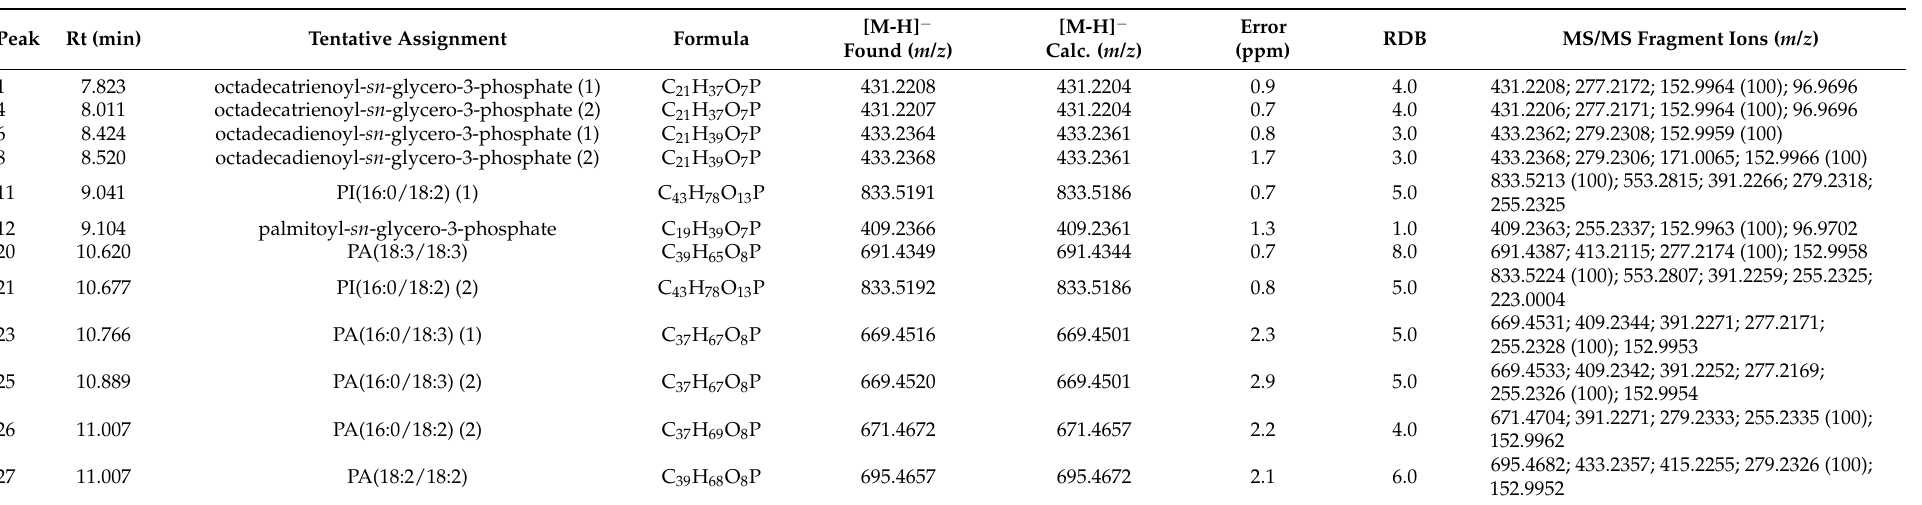
Table 3. TOF-MS and MS/MS data of PAs tentatively identified in apolar extracts from the different Calendula arvensis organs. Peak numbers are based on elution order in the whole reversed-phase chromatograms (RDB: ring and double bond).